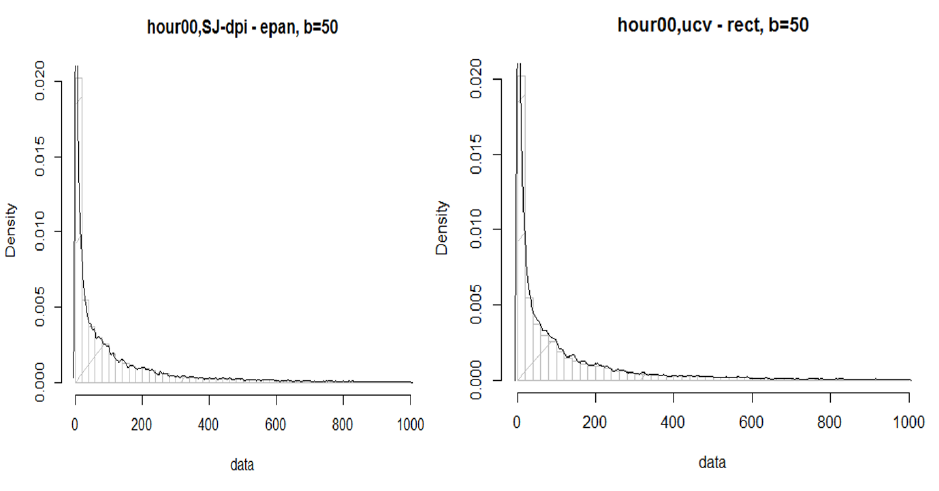
Figure 20. Tail of data, by hour, ST.